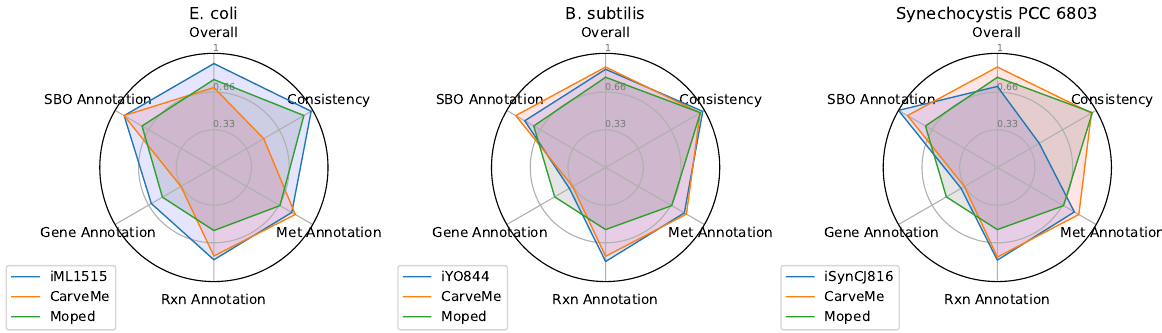
Figure 6. MEMOTE evaluations for draft model reconstructions produced by CarveMe and moped, as well as established models, for E. coli , Bacillus subtilis and Synechocystis sp. PCC 6803. MEMOTE evaluations include the stoichiometric consistency and the annotation level of